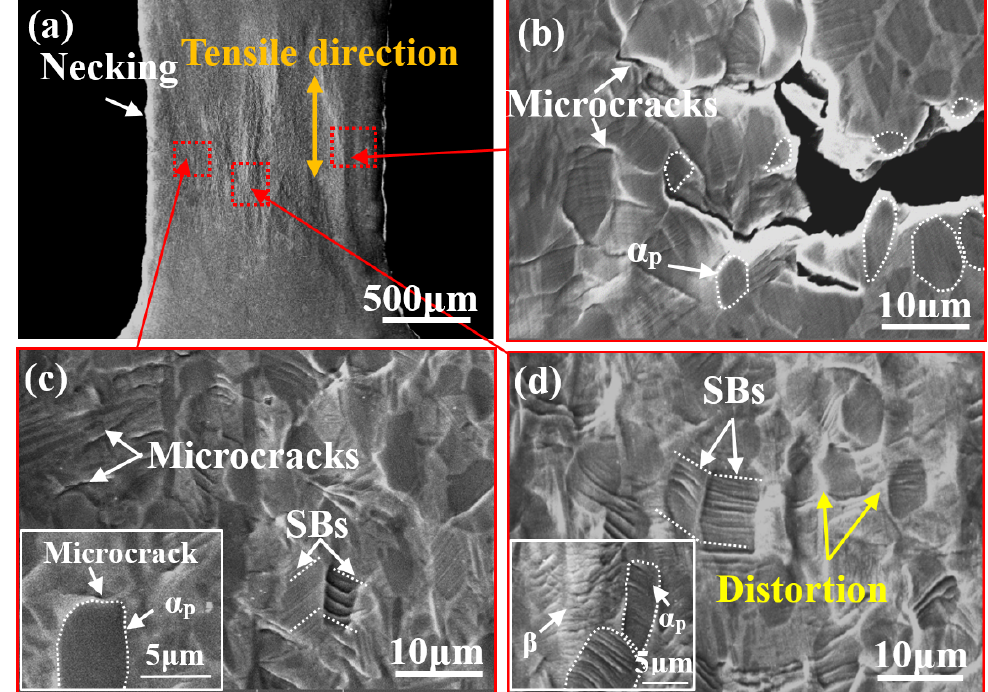
Figure 6. ( a ) In situ SEM images of the bimodal microstructure at position B; ( b ) magnified image showing microcracks formed on the edge of the sample; ( c ) microcracks initiated from the α p / β interface; ( d ) distortion was aggravated around the α p / β interface.